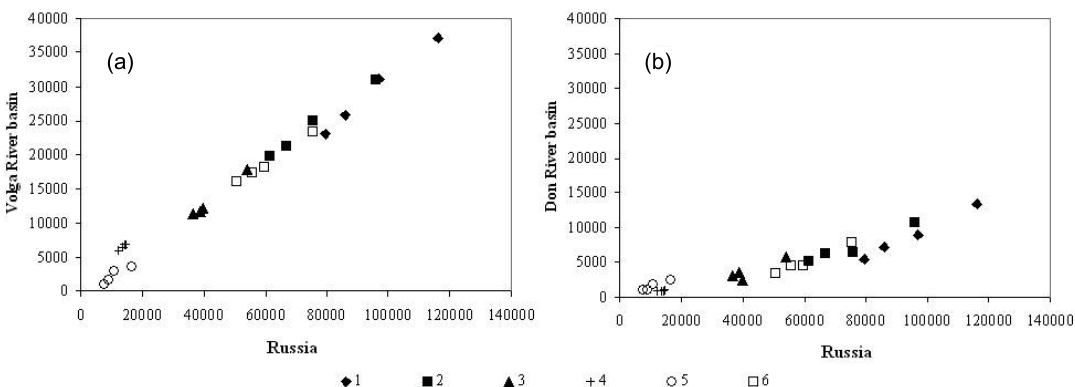
Fig. 1 Water consumption indices in Russia as related to those in the Volga (a) and Don (b) basins (in km 3 /year) in 1990, 1995, 2000 and 2005. (1) the total water amount abstracted; (2) the total water amount used; (3) the water amount used to meet production needs; (4) the water amount used for domestic water supply; (5) the water amount used for irrigation; and (6) the total sewage amount